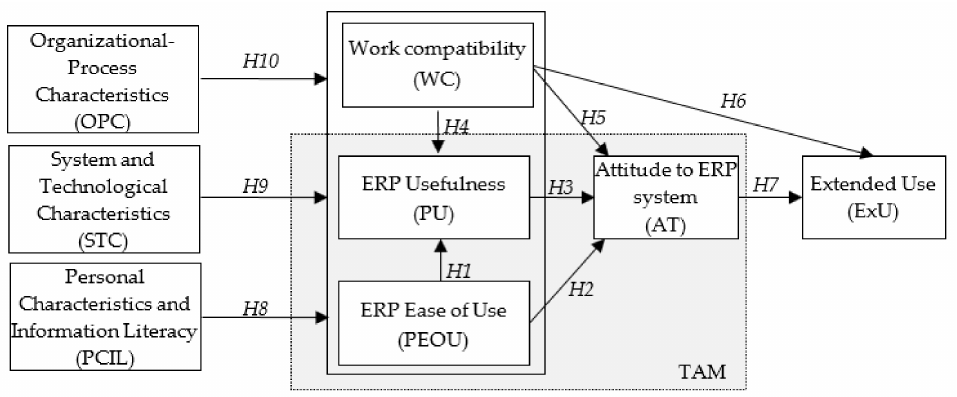
Figure 3. Conceptual Model [30–32,65]; extended by the